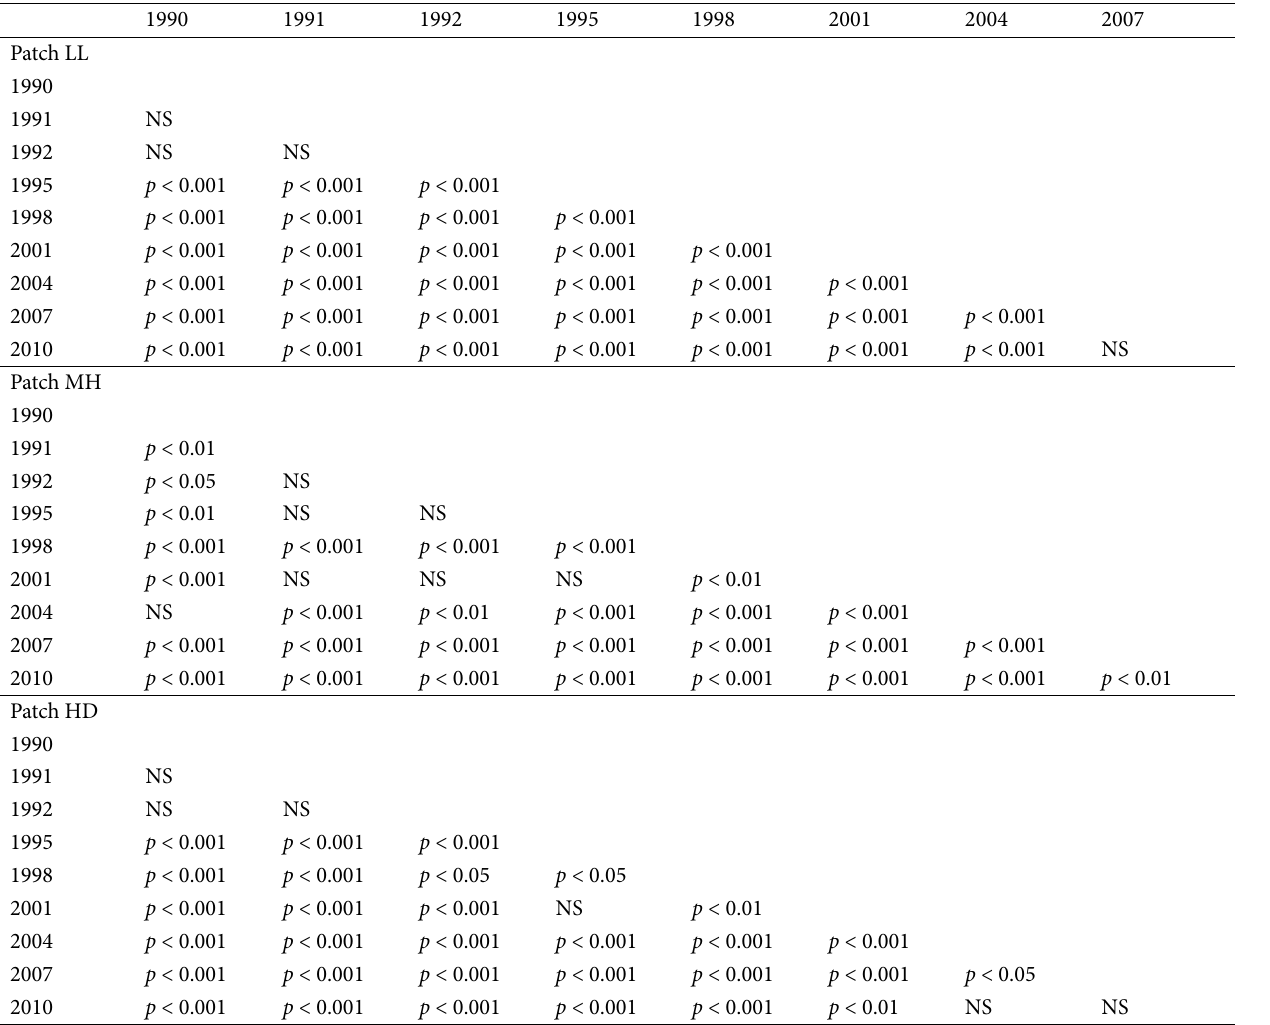
Table 3 The significance of differences in the percentage of juvenile ramets in the study patches of the Senecio umbrosus population; data analyzed with the u